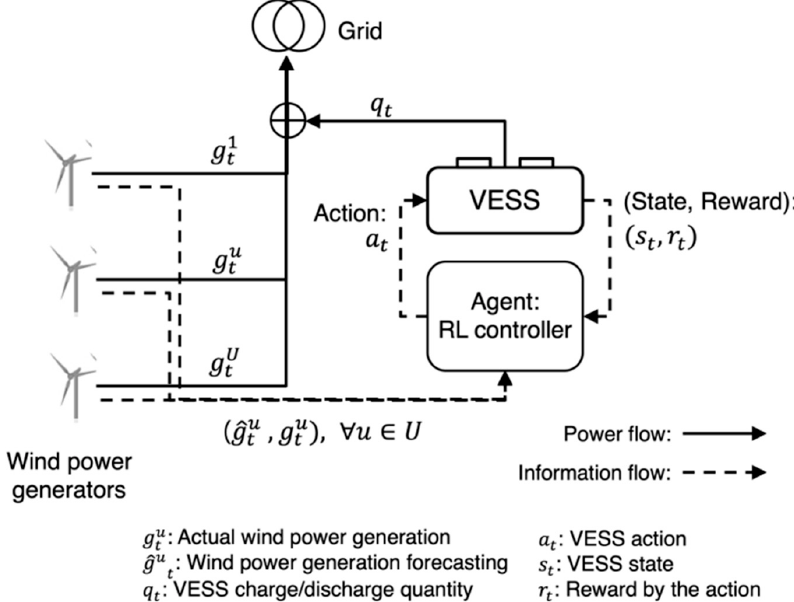
Figure 1. Wind power generation system model with a virtual energy storage system; VESS: virtual energy storage system, and RL: reinforcement learning.